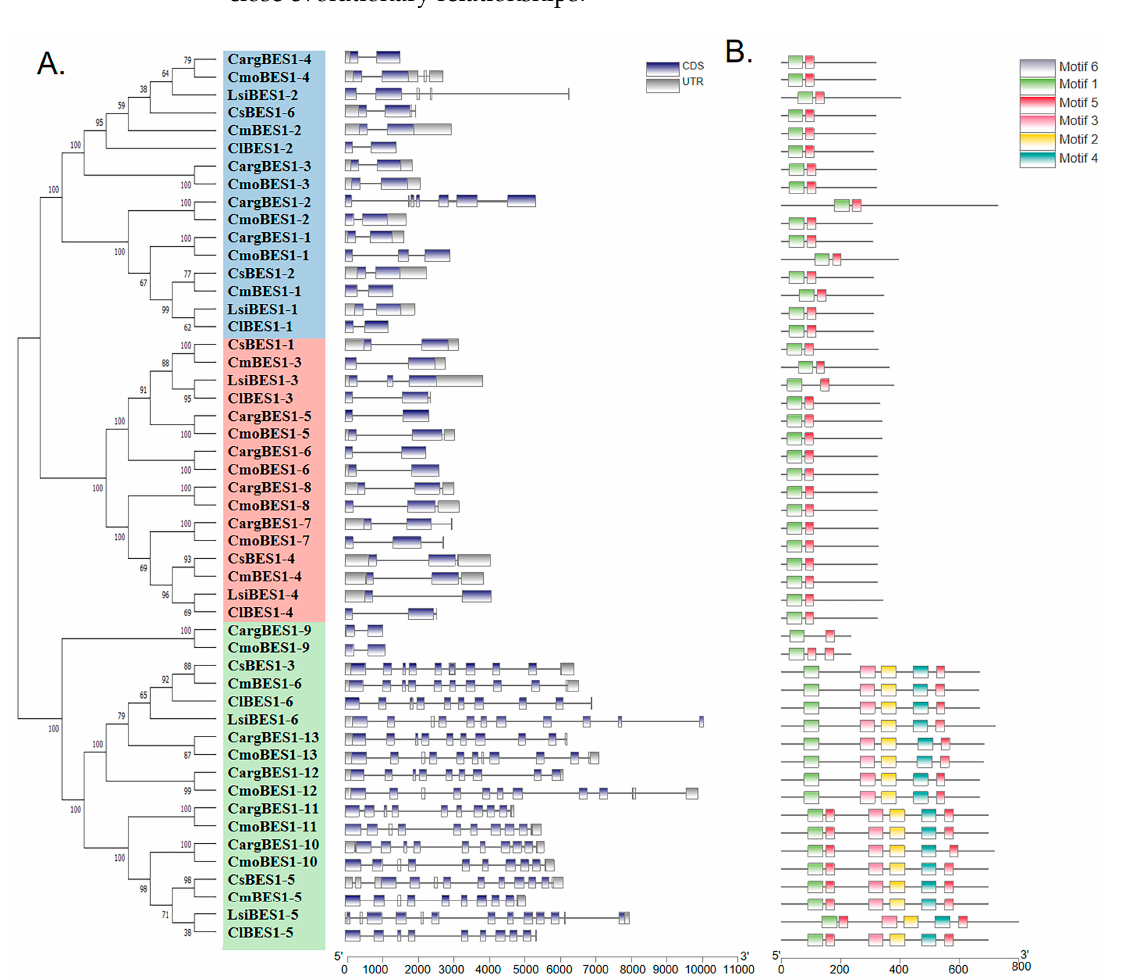
Figure 3. Gene structures ( A ) and conserved motifs distribution ( B ) of BES1s in six Cucurbitaceae species (silver-seed gourd, watermelon, cucumber, winter squash, bottle gourd, and melon). The CDS were represented by blue boxes, and the UTRs were represented by gray boxes. Motif analysis was conducted using the MEME online software (https://meme-suite.org/meme/tools/meme, accessed on 31 August 2022) and TBtools software (v1.108) as described in the Materials and Methods Section 4.4. Different color boxes represented various types of conserved motifs.